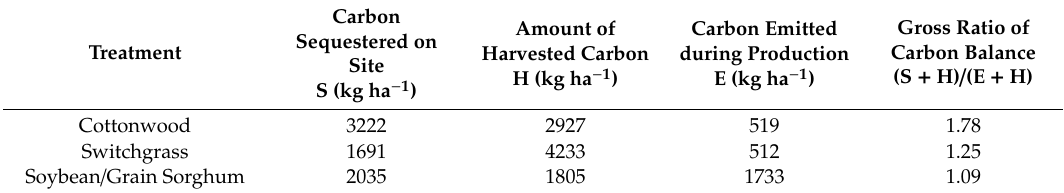
Table 7. Gross ratio of carbon production when emission from the combustion of harvestable biomass is included (using the procedure described by Heller et al.